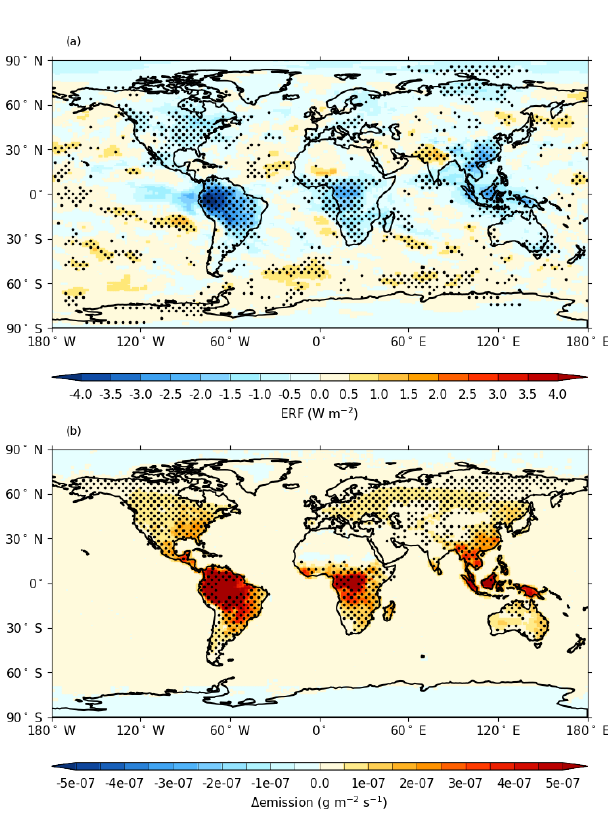
Figure 4. Multi-model mean (a) ERF from piClim-2xVOC vs. piClim-control , (b) change in BVOC emissions for abrupt-4xCO2 vs. piControl . Stippling shows areas where the mean changes by more than the standard deviation across